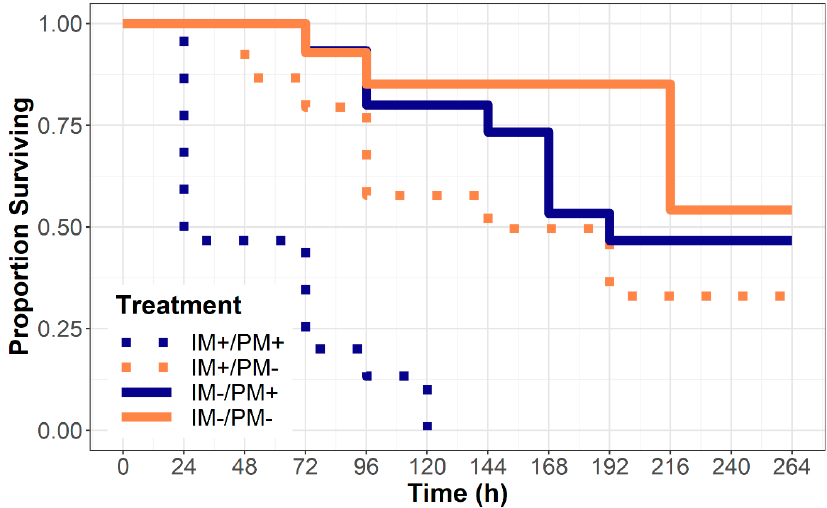
Figure 1. Survival of the obligately mycophagous beetle larvae, P. vigintimaculata, after being confined to leaves from plants either treated or untreated with imidacloprid (IM+/IM − ) and either infected or uninfected by powdery mildew fungus Podosphaera xanthii (PM+/PM − ). The larvae confined to uninfected leaves (PM − ) were regularly provided sustenance by way of supplemental leaf discs from infected and untreated plants.